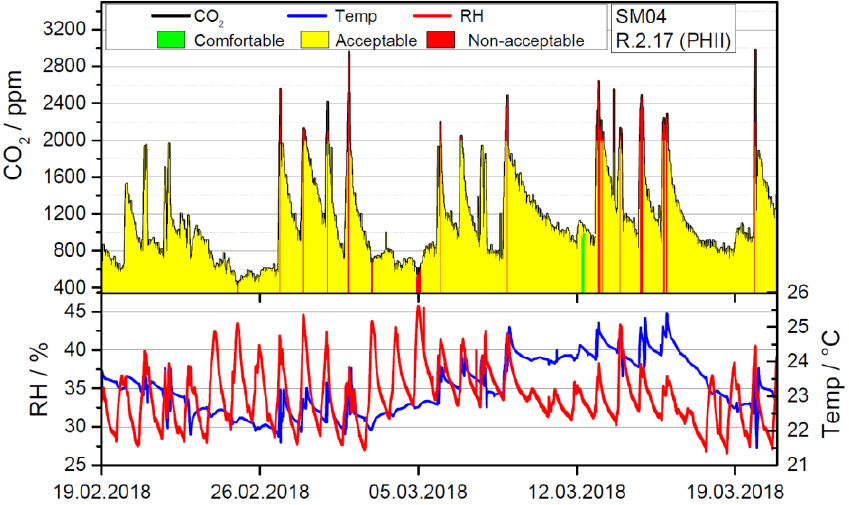
Figure 6. Transient evaluation of temperature, humidity and CO 2 concentration in room R2.17 in the period between 19.02.2018 and 19.03.2018. Due to overheating the thermal comfort was only medium throughout the week. The CO 2 levels have been recorded to be above 2000 ppm almost every day at some point.